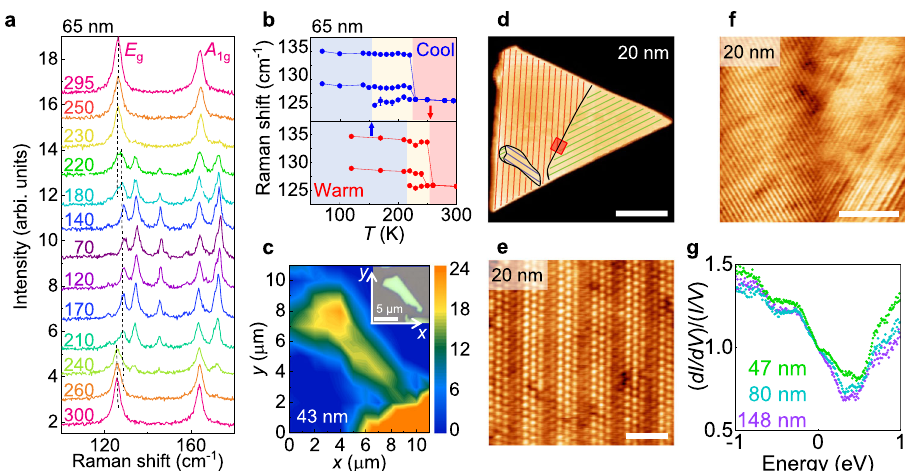
Fig. 2 Stripe charge ordering formation in IrTe 2 nano fl akes. a , b Raman spectra ( a ) and corresponding temperature dependent Raman frequency ( b ) of a 65-nm-thick IrTe 2 nano fl ake at various temperatures during cool-down and warm-up procedures. At T < T s , the Raman modes, E g at 126 cm − 1 and A 1g at 165 cm − 1 , split into multiple peaks as the fl ake forms the stripe charge order in a . The temperature ranges for the normal (red), the stripe (blue), and intermediate coexistence (yellow) phases, are identi fi ed in b , during cooling (upper panel) and warming (lower panel). Transition temperatures T s ,dn and T s fi le of Raman intensity map for 129 cm − 1 for a 43-nm-thick IrTe fl ake at T ~ 70 K. Inset: ,up are indicated by the arrows, respectively. c Spatial pro 2 nano optical microscope image of the fl ake. d Large-scale scanning tunnelling microscopy (STM) image of a 20-nm-thick IrTe 2 fl ake at T = 85 K (scale bar, 300 nm). The fl ake has only stripe-phase charge-ordered domains, illustrated by red, green, and blue lines. Black lines indicate domain boundaries between three equivalent stripe-phase charge-ordered domains. e Atomically resolved STM image of d at T = 85 K representing a uniform striped area with 5 × 1 surface reconstruction (scale bar, 2 nm). f Zoomed-in STM image of two charge-ordered phases indicated by red square in d showing that the two phases coexist at the boundary (scale bar, 20 nm). g Scanning tunnelling spectroscopy (STS) spectra at T = 85 K taken on IrTe 2 nano fl akes with d = 47, 80, and 148 nm, as indicated in the